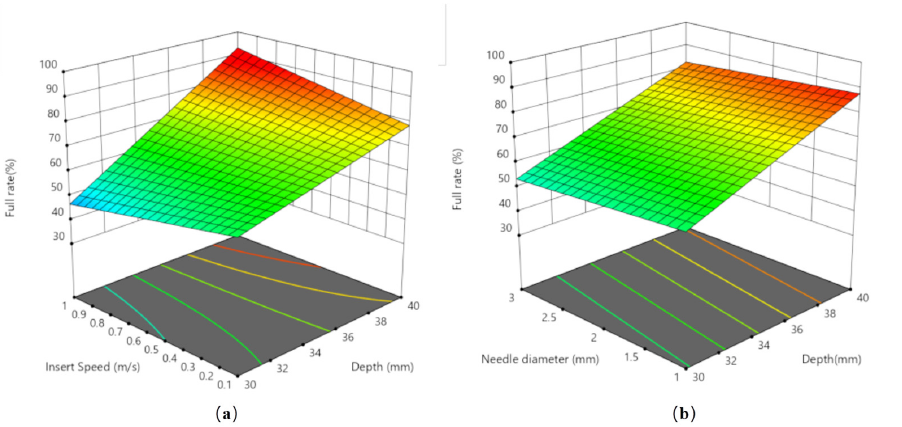
Figure 7. Response surface analysis of factors interaction: ( a ) is the interactive response surface of the insertion/grasping speed and the insertion depth of the steel needle, ( b ) is the interactive re ‐ sponse surface needle diameter and the insertion